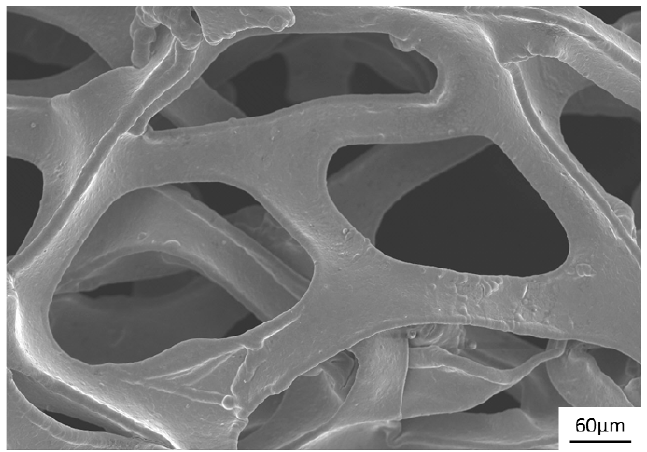
Figure 12. The SEM image of the initial nickel foam surface.